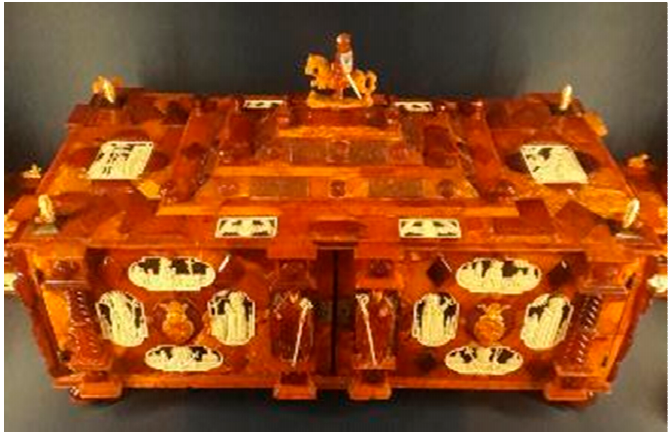
Figure 7. Danzig workshop, Reliquary of St. Kazimierz Jagiello ń czyk, c. 1677–1678. Palazzo Pitti (Tesoro dei Granduchi), Florence. Photo by the author.